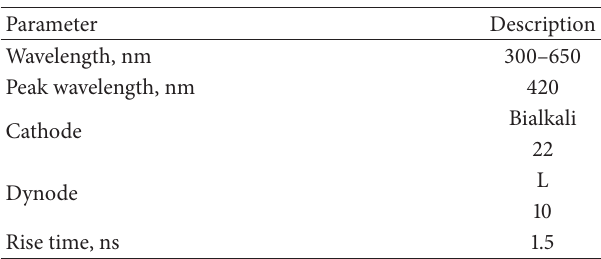
Table 3: Properties of the